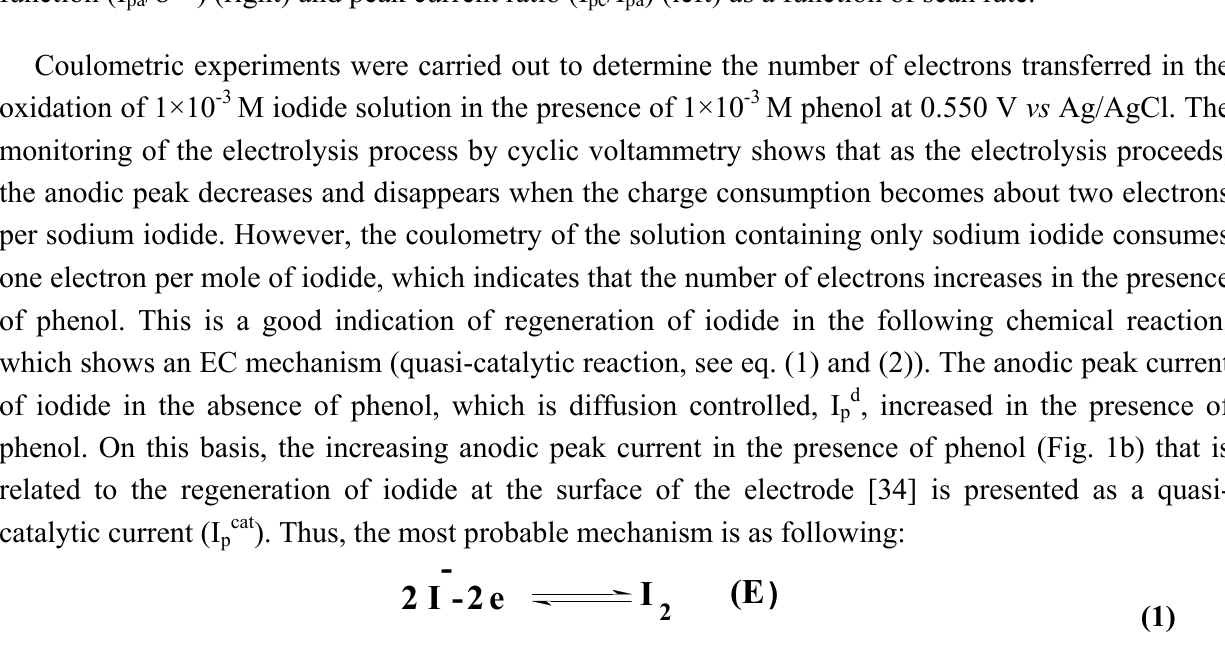
/I ) (left) as a function of scan pc pa